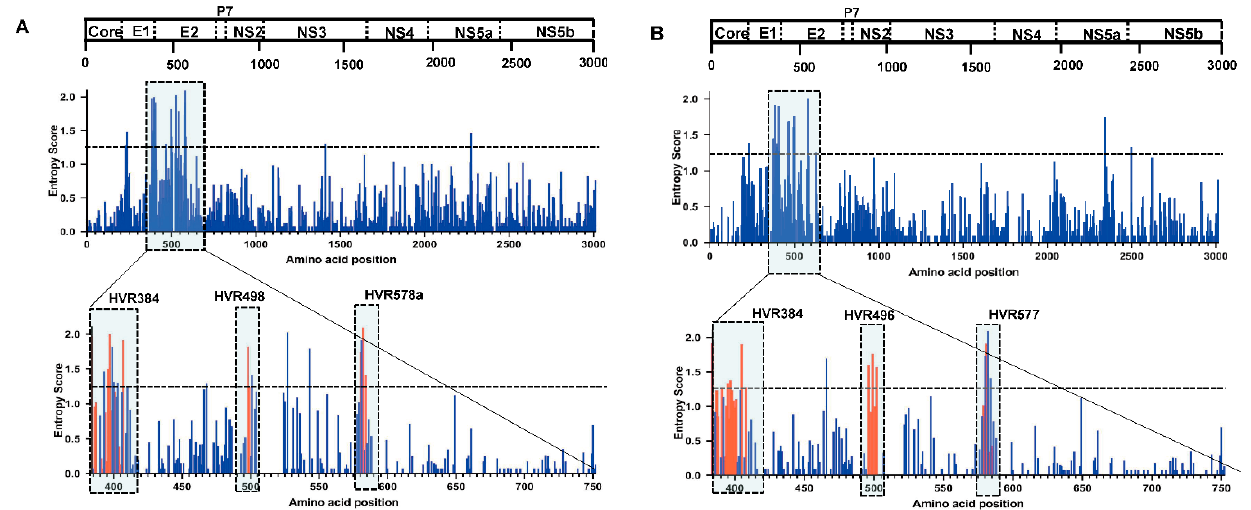
Figure 1. Full-genome sliding window plot for GT-3a and GT-3b nucleotide diversity (%). The GT- 3a and GT-3b were plotted separately in color-coded solid lines.